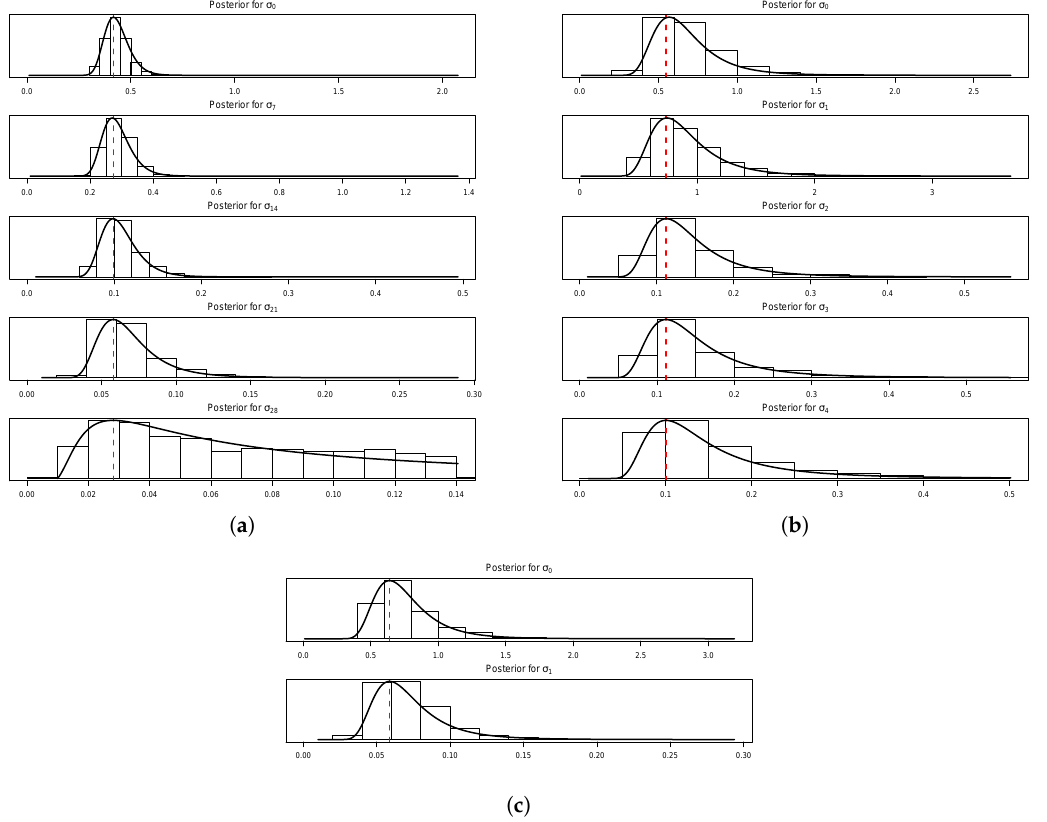
Figure 3. Posterior distributions for σ j for the ( a ) Motor Third Part Liability (MTPL) ( b ) Property and ( c ) Motor Hull lines of business. One sees solid lines representing the unnormalized posteriors, the histogram of the Markov Chain Monte Carlo (MCMC) outputs and a red dashed line indicating the CL standard deviation estimate. Note that for LoB MTPL we only plot selected development periods: j ∈ { 0,7,14,21,28 }